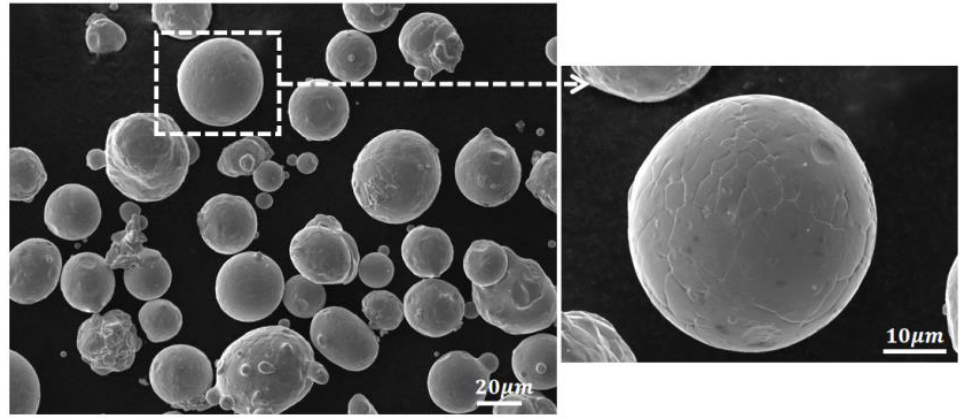
Figure 1. SEM of CoCrFeNiMn HEA powder.